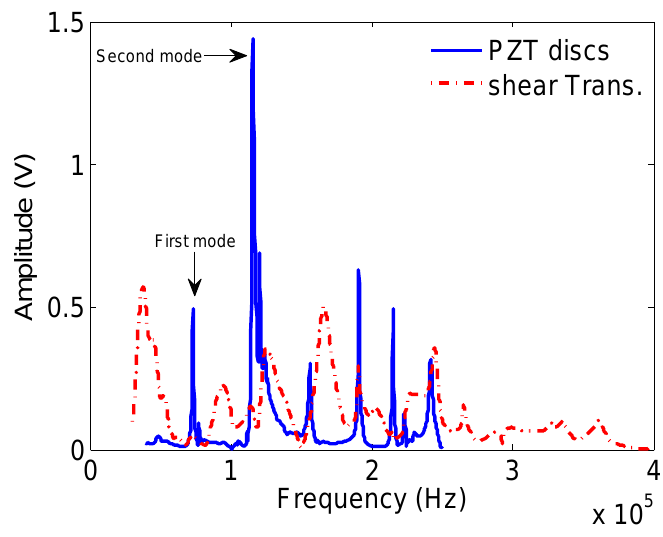
Figure 4. Comparison between the spectra obtained using the shear wave and the piezoelectric disc transducers for the same disc ternary sample Fe 63 Ti 29 Al 8 (composition given in percentage by weight).